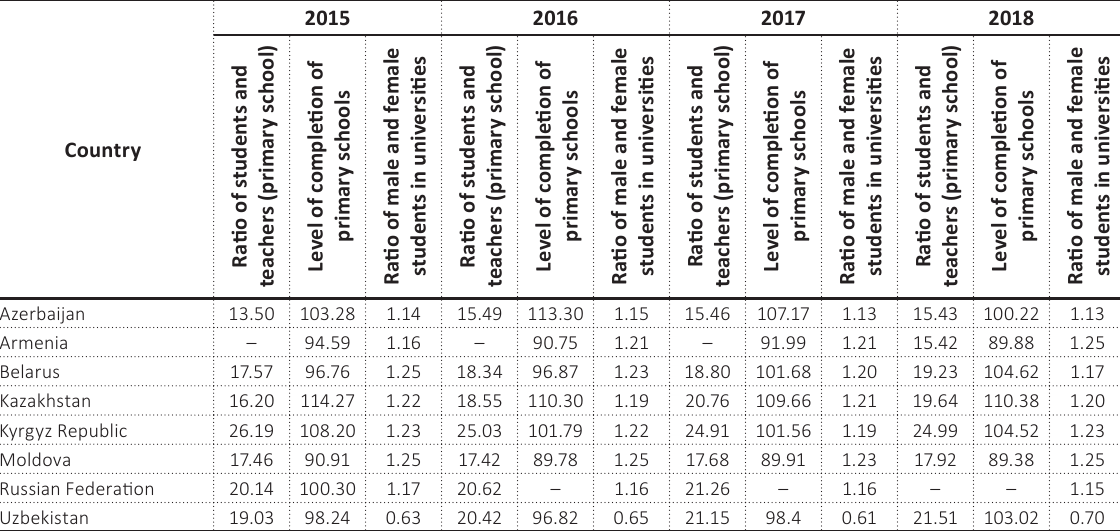
Table 3. Ratio of students and teachers (primary school), level of completion of primary schools, ratio of male and female students in universities, %